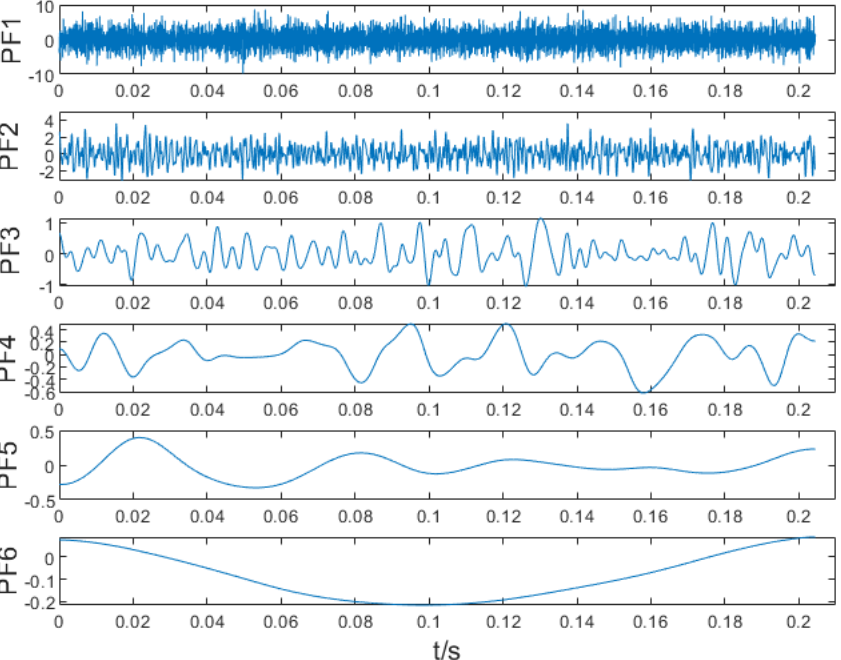
Figure 3. The components obtained after the RLMD decomposition of the simulated signal. Table 1. The kurtosis value of each PF component and the correlation coefficient with the original signal.